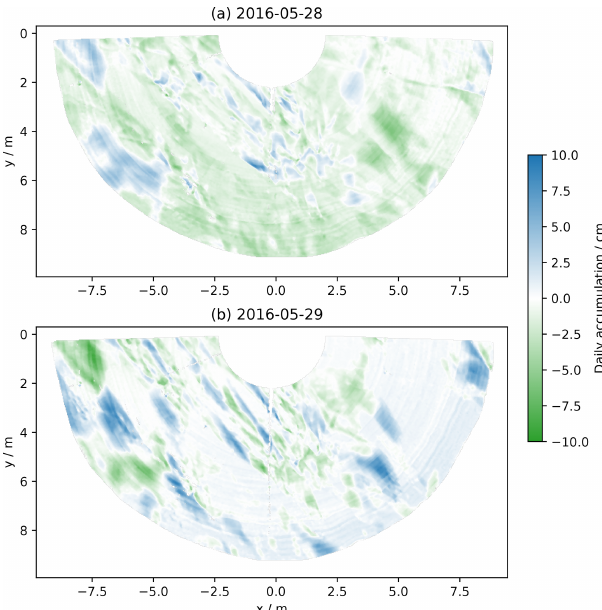
Figure 8. Accumulation between 28 and 29 May 2016 (a) and 29 and 30 May 2016 (b) .